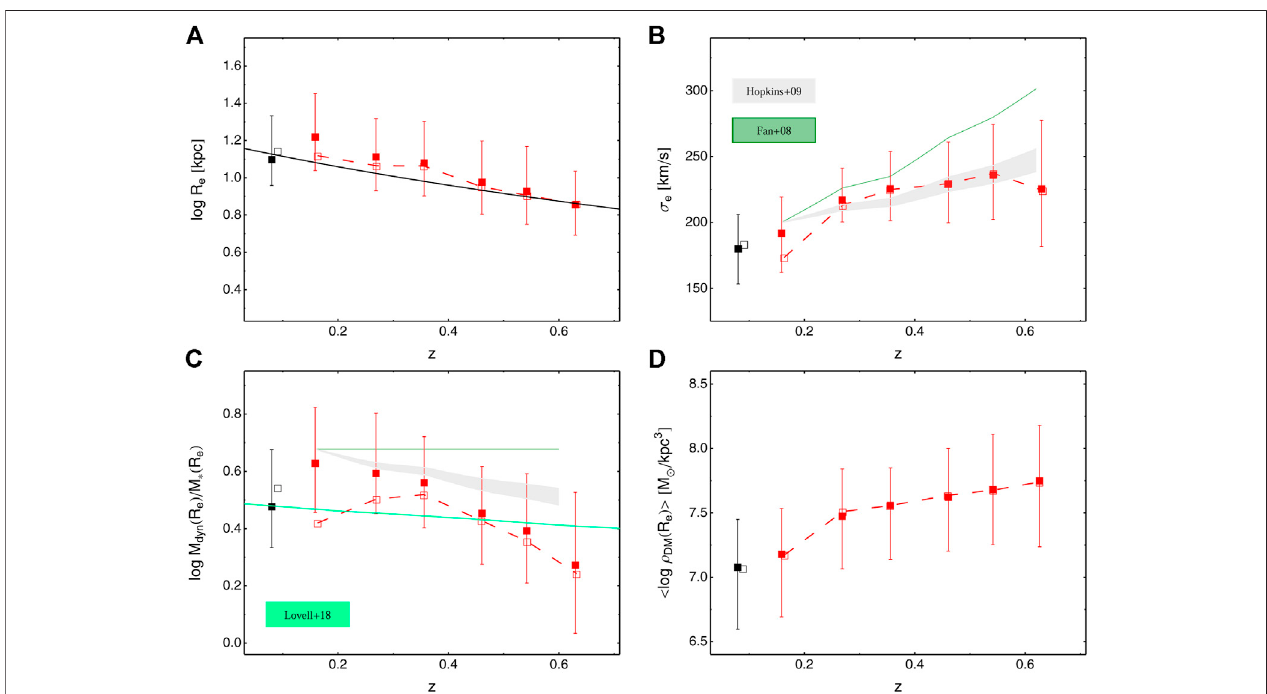
FIGURE 4 | Evolutionwithredshiftof(log) R e (A) , σ e (B) ,(log) M dyn / M p (C), and(log) 〈 ρ DM 〉 (D) forlog M p / M ⊙ > 11.2.Redsymbolsareasintheprevious fi gures.Open blacksquarewitherrorbarismedianand25 – 75thpercentilesforSPIDERgalaxies,whileopenblacksquareisthemedianfortheSPIDERsamplewhentheprogenitorbiasis taken into account. The black solid line in the top panel is taken from the average R e / R e, 0 – z trends (with R e, 0 (cid:1) R e ( z ∼ 0)) for spheroid-like galaxies in Trujillo et al. (2007) normalizedto R e,0 (cid:1) 15kpc.ShadedgrayregionandgreenlineareourpredictionsusingthemergingmodelofHopkinsetal.(2009)andthe “ puf fi ng-up ” scenariofrom Fan et al. (2008), respectively. The cyan line in the bottom-left panel is for galaxies with a stellar mass of ∼ 10 11 M ⊙ from IllustrisTNG simulations (Lovell et al., 2018). See explanations in the main